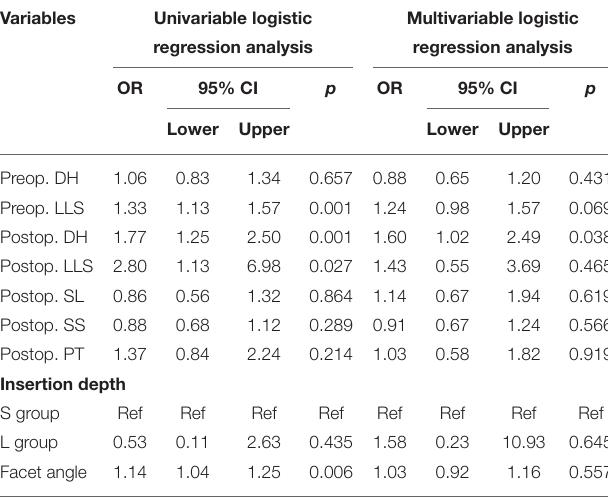
TABLE 5 | Univariate and multivariate logistic regression analysis of unfavorable clinical outcomes in the long-term cohort. Variables Univariable logistic